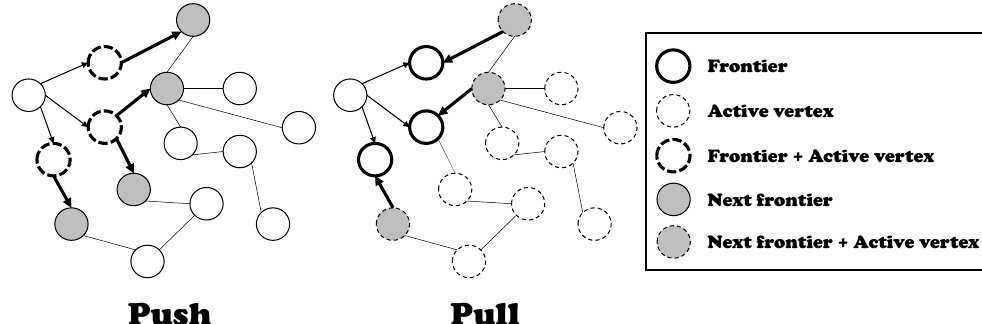
Figure 2. Push and pull mechanism in direction-optimizing